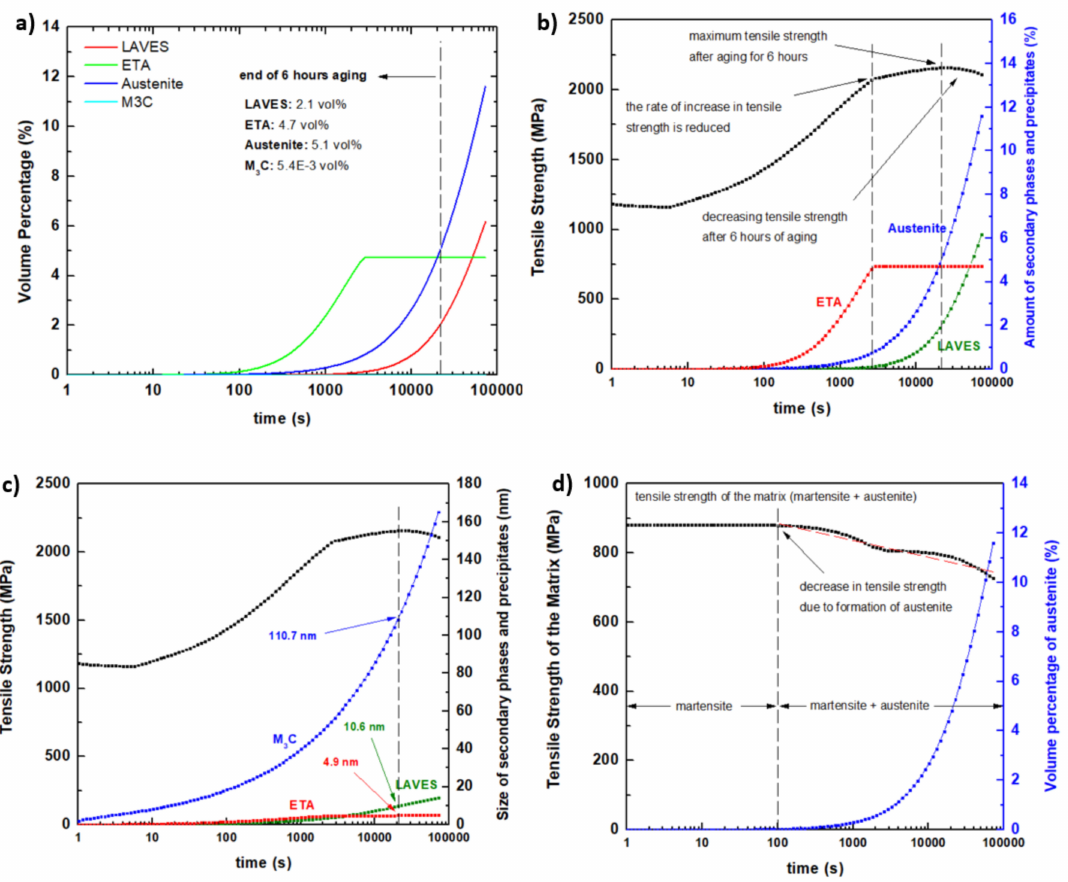
Figure 11. The dependence of ( a ) volume fraction of precipitates and secondary phases on aging time. The e ff ects of ( b ) the type of phases, and ( c ) size of the precipitates on tensile strength during the aging process. ( d ) The impact of increasing reverted austenite on the tensile